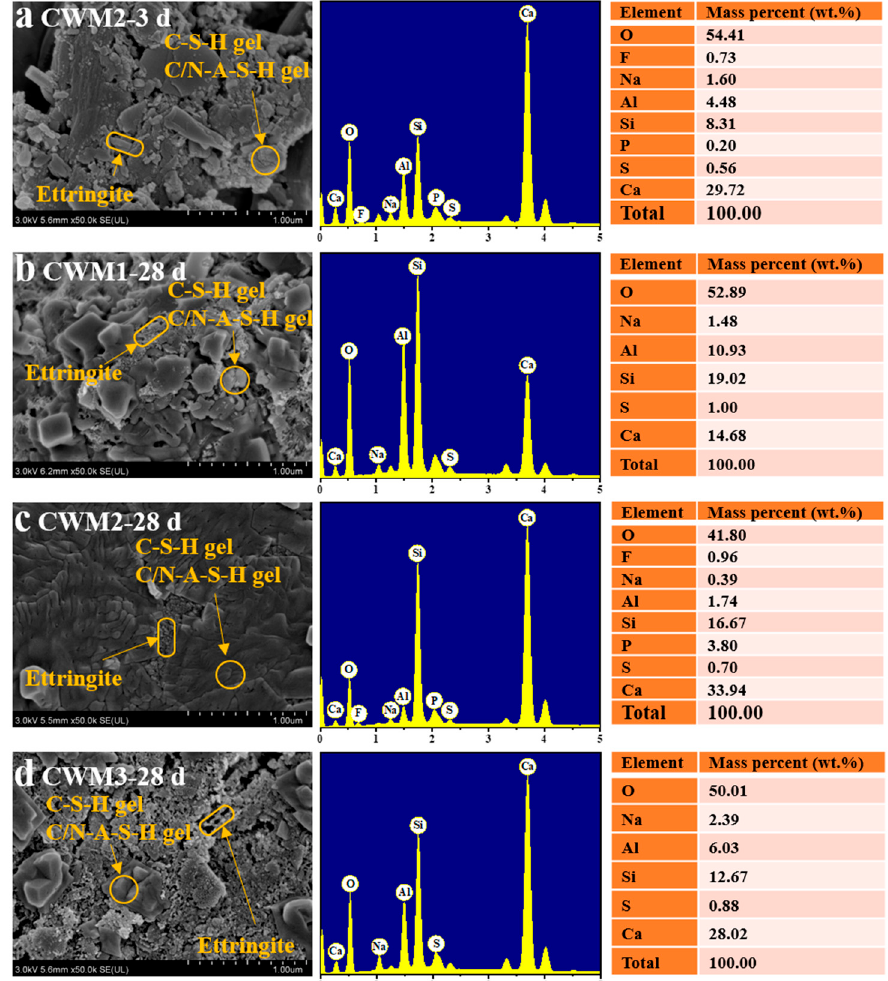
Figure 13. SEM-EDX of ( a ) CWM2-3 d, ( b ) CWM1-28 d, ( c ) CWM2-28 d, and ( d ) CWM3-28 d.